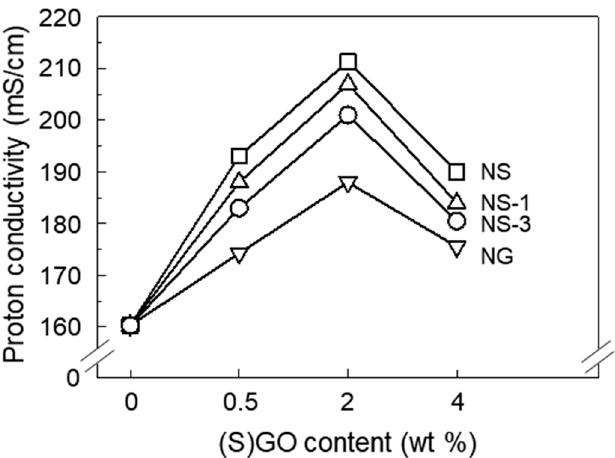
Figure 4. Proton conductivity of recast Nafion and its composites with GO, SGO, and SGO / ceria in varying filler content at 100% relative humidity (RH).